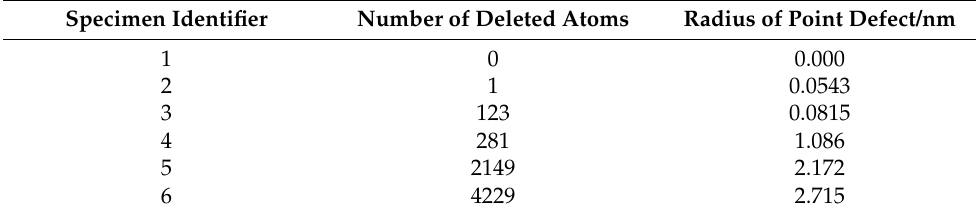
Figure 1. Cell model of monocrystalline silicon and 6 specimens with point defects. Table 1. The size of point defect in different specimens.